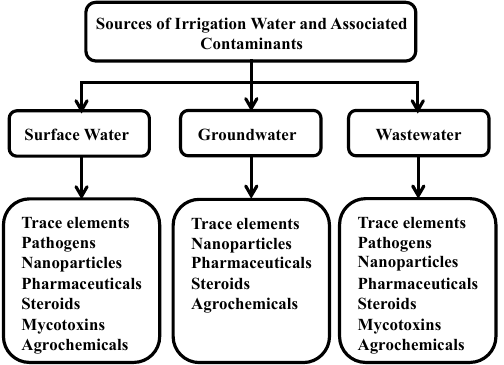
Figure 1. Main sources of irrigation water and different types of contaminants present in those sources impacting food, soil, and water quality. Note that surface water and wastewater are subject to similar types of contamination.